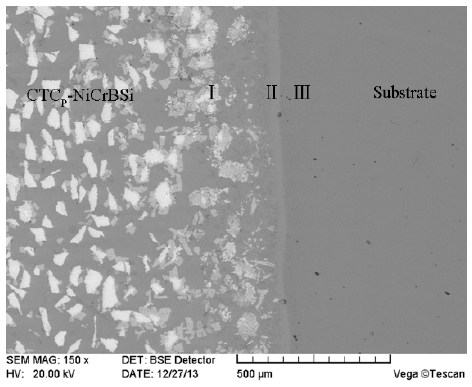
Figure 13. SEM image of the interface between modified CTC P -NiCrBSi and substrate.